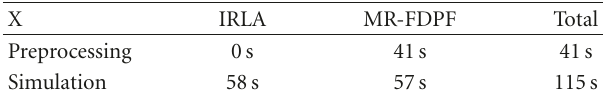
Table 4: Performance of the model: simulation times (on PC, 2.4GHz, 2 GbRAM). X IRLA MR-FDPF Total Preprocessing 0s 41 s 41s Simulation 58s 57 s